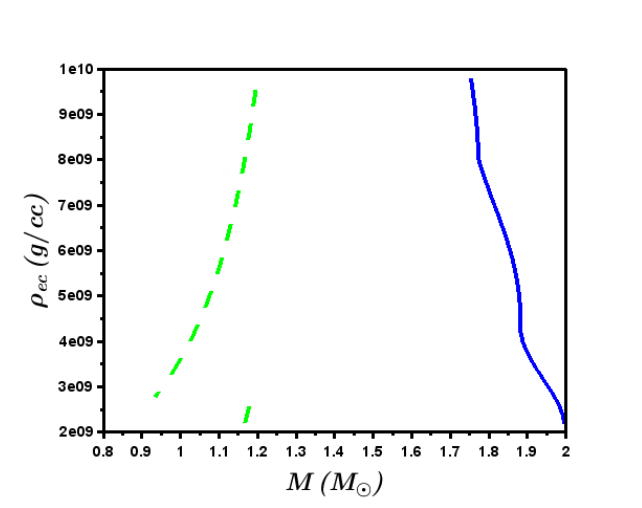
Figure 10: Comparison of M − ρ relation (solid blue line) with that of the hypo- ec thetical case with Chandrasekhar’s EoS but Lorentz force intact (dashed green